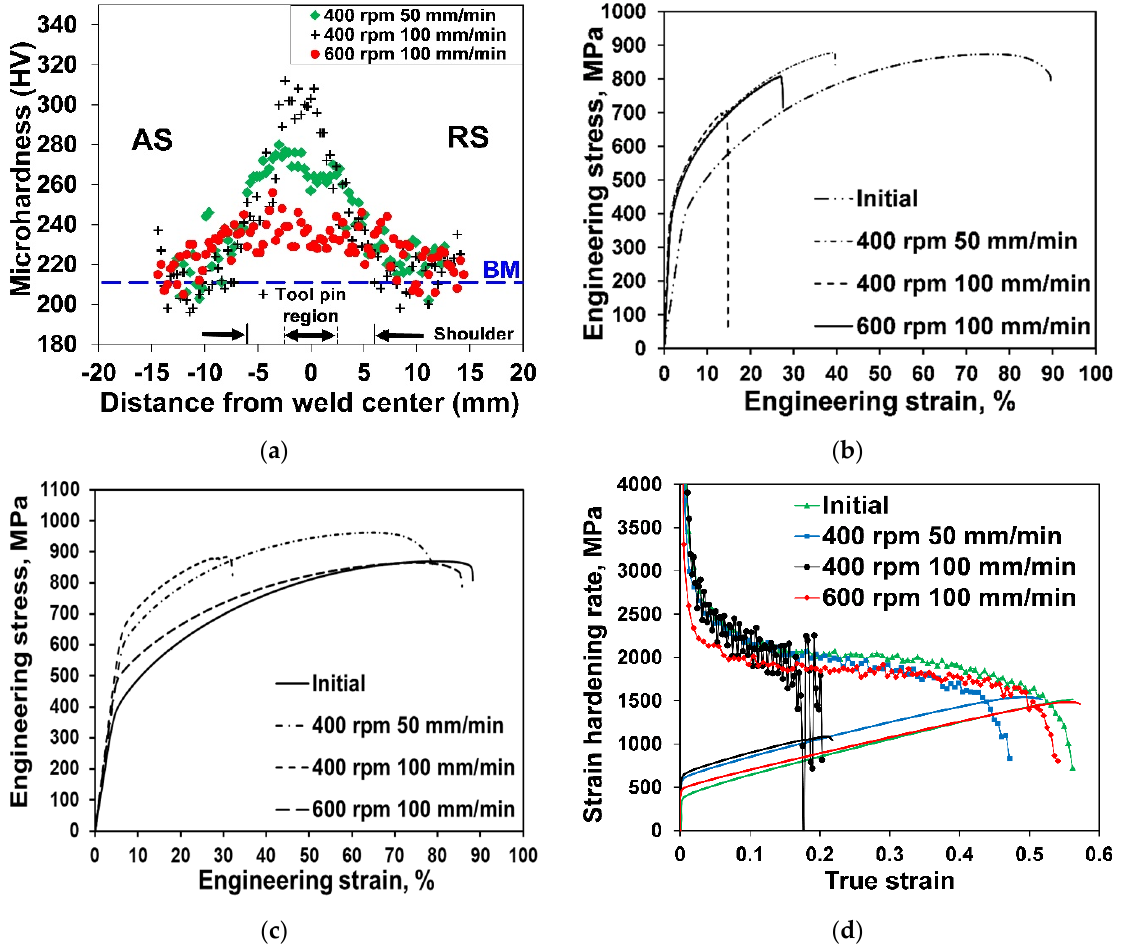
Figure 7. Mechanical properties of welds in the Fe 49 Mn 30 Co 10 Cr 10 C 1 alloy produced by FSW at various parameters: microhardness profiles across the welds ( a ); engineering stress–engineering strain curves of the transversal ( b ) and longitudinal specimens ( c ) and strain hardening rate of the longitudinal specimens ( d ).